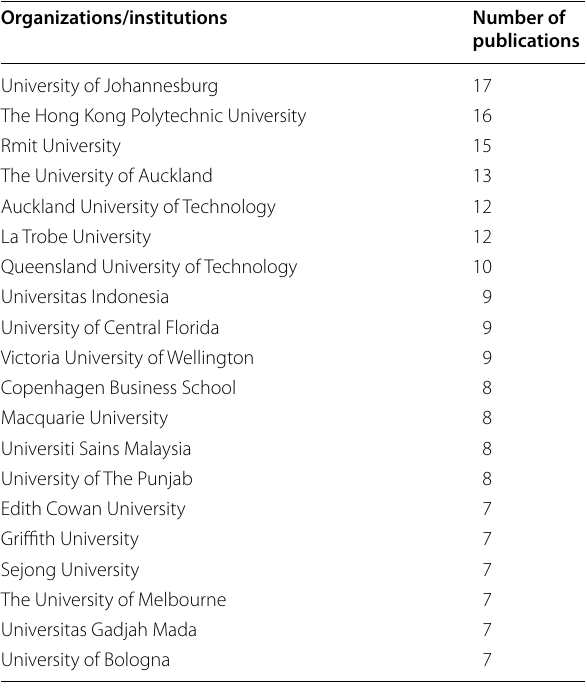
Table 5 Top 20 organizations contributing to the topic of